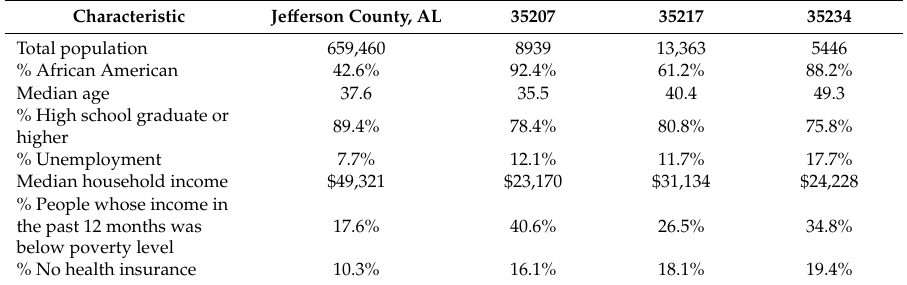
Table 1. Population characteristics of North Birmingham zip codes compared to Je ff erson County,